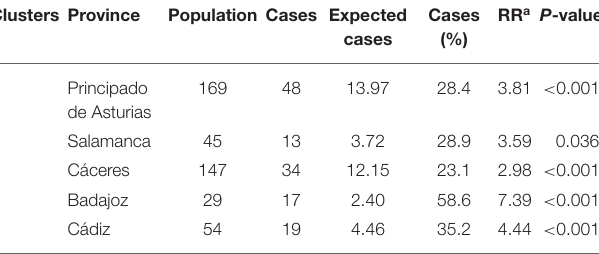
TABLE 4 | Results of the spatial analysis for Campylobacter fetus subsp. venerealis in breeding bulls from extensive beef herds in Spain. Clusters